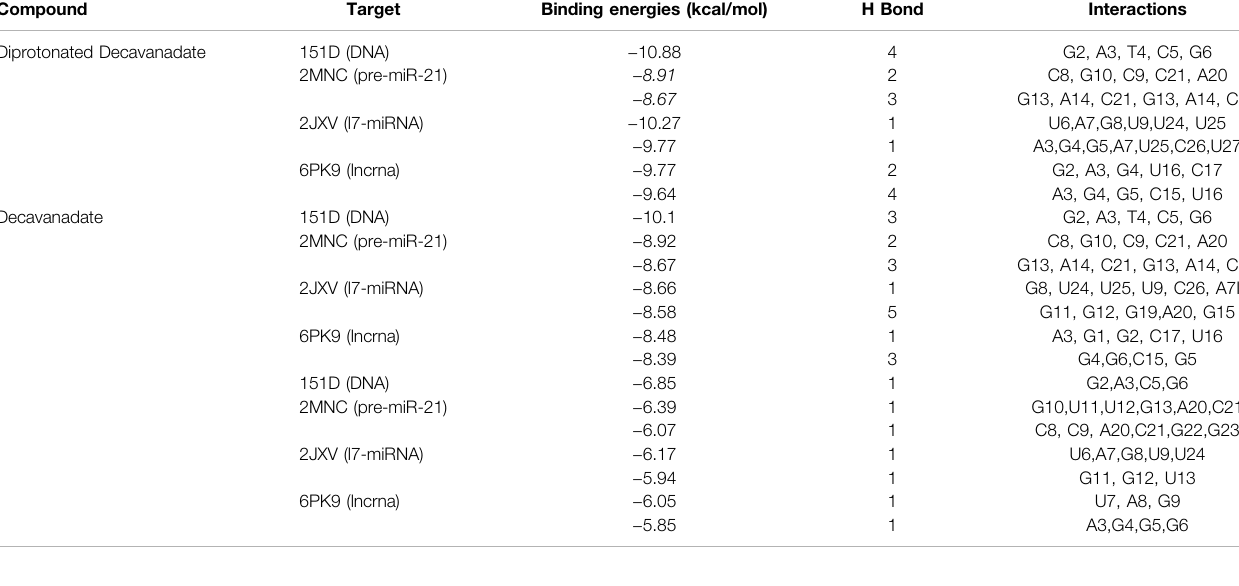
TABLE 4 | Molecular docking results. Binding energies for the deprotonated decavanadate anion best molecular poses with DNA tRNA and lncRNA. Compound